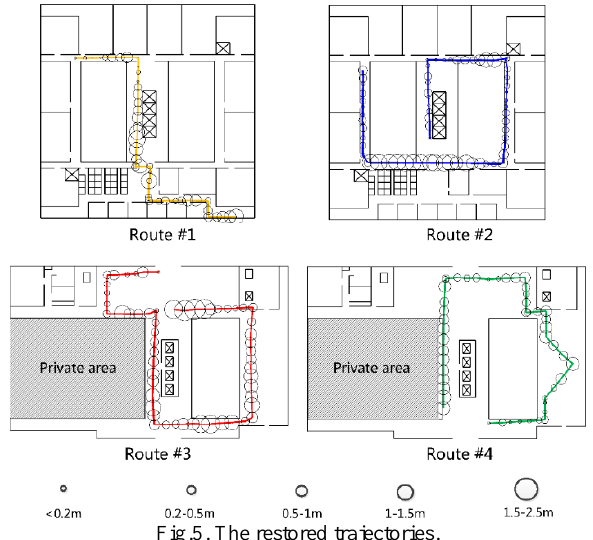
Fig.5. The restored trajectories.